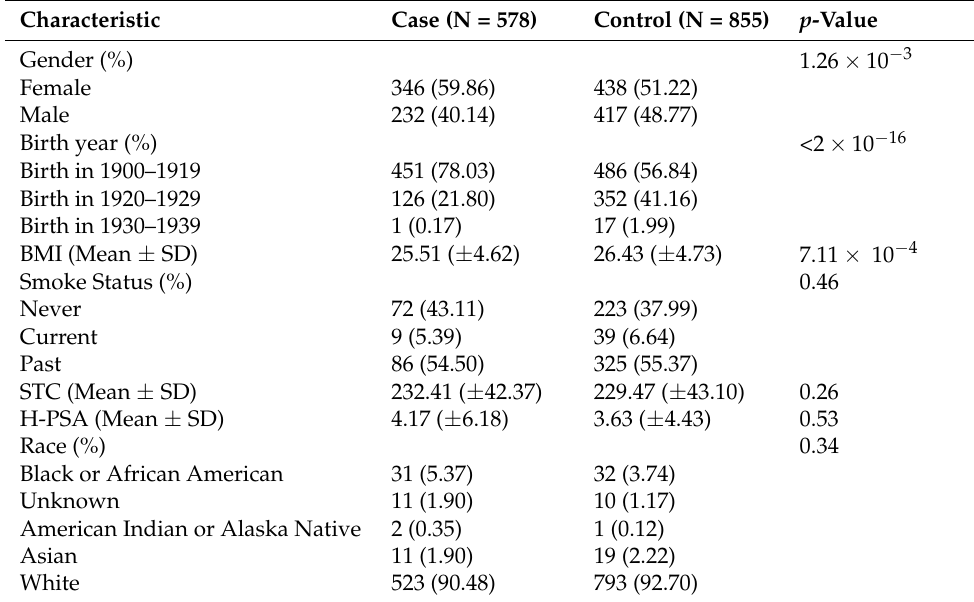
Table 1. Demographic and clinical characteristics of the patients (full analysis population).